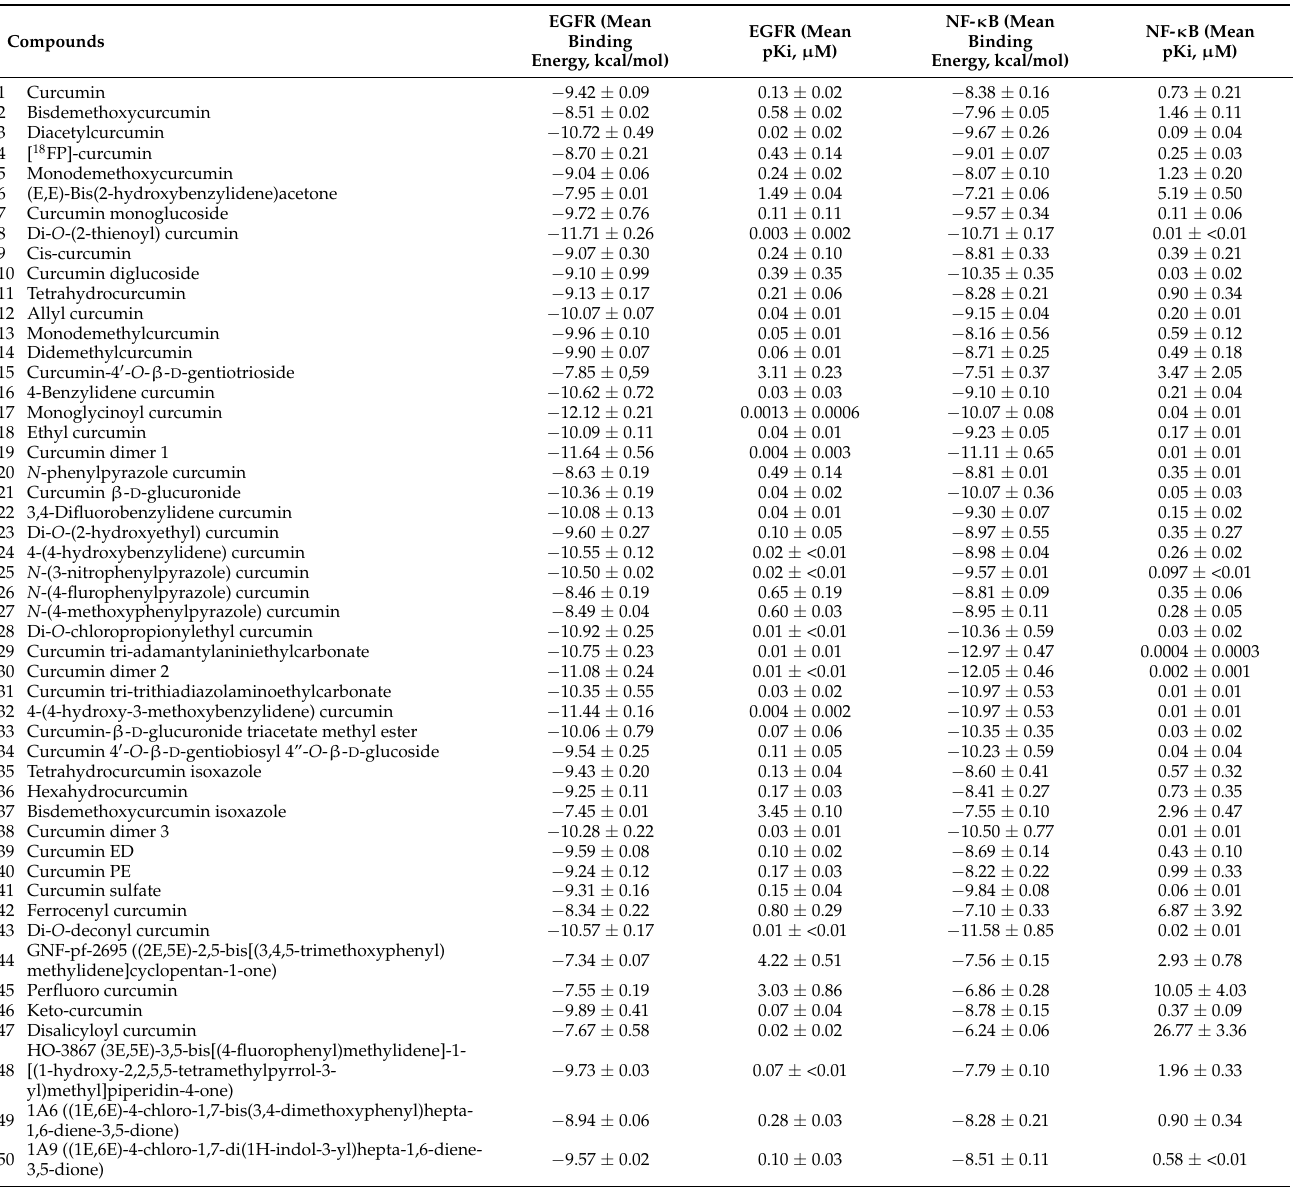
Table 1. Mean binding energies and predicted binding constants were obtained by molecular docking for 50 curcumin compounds. Dockings were independently carried out three times with every 250,000 runs (mean values ±